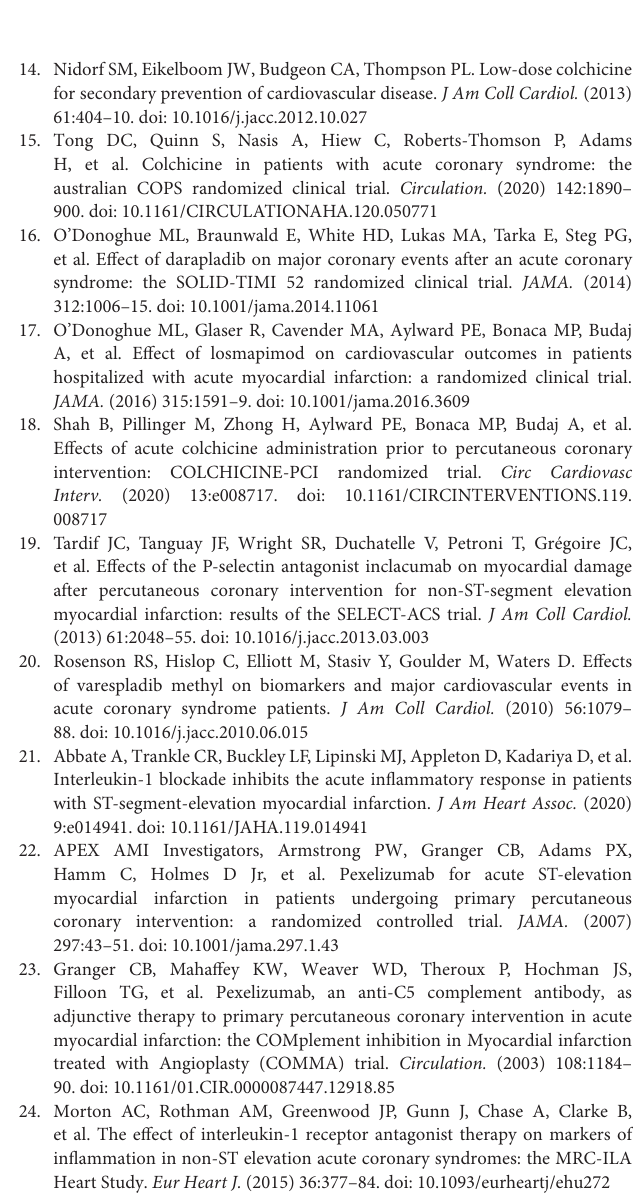
Supplementary Figure 9 | Forest plots of studies evaluating primary end points in patients with stable CHD vs. ACS. Supplementary Figure 10 | Forest plots of studies evaluating all-cause mortality in patients with stable CHD vs. ACS. Supplementary Figure 11 | Forest plots of studies evaluating cardiac mortality in patients with stable CHD vs. ACS. Supplementary Figure 12 | Forest plots of studies evaluating stroke in patients with stable CHD vs. ACS. Supplementary Figure 13 | Funnel plots of odds ratios and standard errors to assess the publication bias of colchicine vs. placebo in primary end points. Supplementary Figure 14 | Funnel plots of odds ratios and standard errors to assess the publication bias of anti-inflammatory agents vs. placebo in infections. Supplementary Figure 15 | Funnel plots of odds ratios and standard errors to assess the publication bias of anti-inflammatory agents vs. placebo in